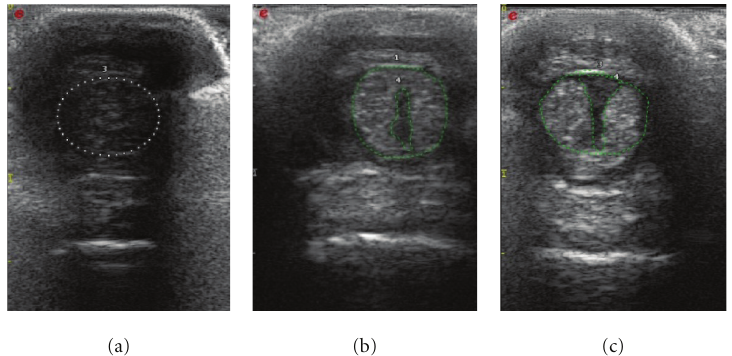
Figure 8: Transversal image at day 7 (a), day 21 (b), and day 42 (c), when the lesion is bigger than at day 21.